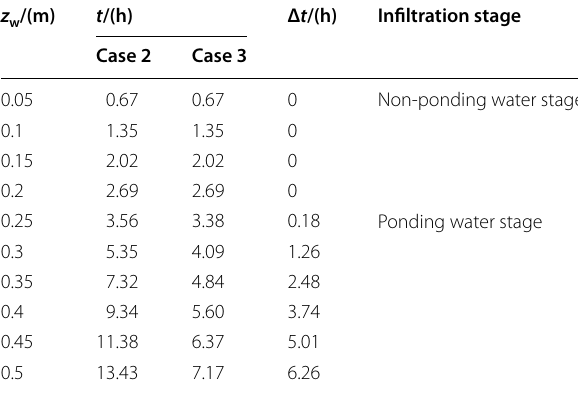
Table 5 Calculation cases of shallow infinite slope